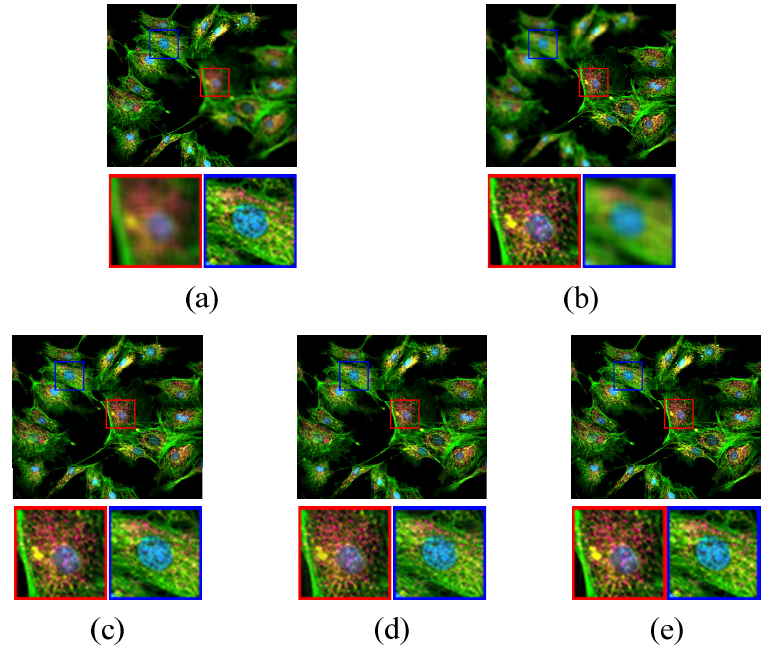
Figure 6. Fusion Results of Multi-focus Fluorescence Image - 1, ( a , b ) are source images, ( c – e ) are fused image of KSVD, JPDL, and proposed method